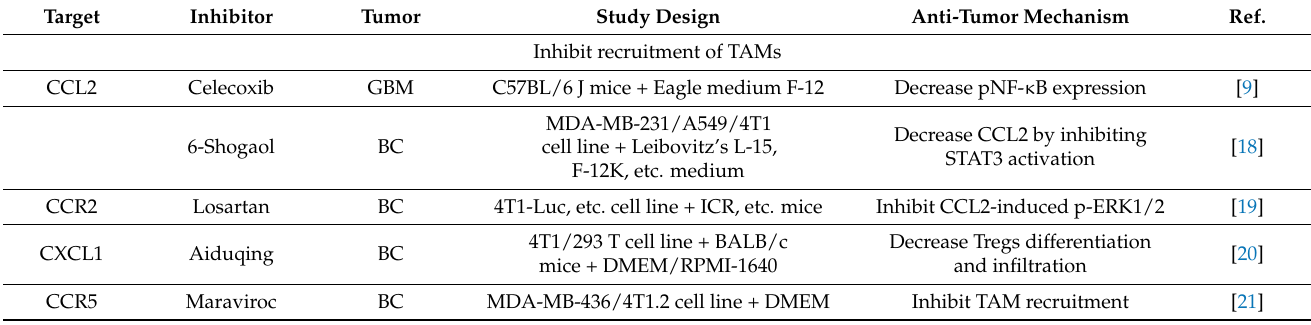
Figure 1. Targeting approaches for inhibiting TAM recruitment and polarization. TAMs are mainly recruited by the factors derived from stromal and tumor cells. These factors, including endosialin, chitinase 3-like protein (Chi3L1), C–C motif chemokine ligand 2 (CCL2), etc., could bind with their receptors in TAMs, then activating the downstream effectors to regulate the recruitment of TAMs through nuclear factor kappa-light-chain-enhancer of activated B cells (NF- κ B), phosphoinositide 3-kinase/protein kinase B (PI3K/Akt), mitogen-activated protein kinase (MAPK), etc. signaling pathways. Targeting inhibitors, including IgG78, celecoxib and GDC0623 block CD68, the NF- κ B and MEK signaling pathways inhibit TAM recruitment or reduce the number of TAMs. The polarization of TAMs is mediated by interleukins, extracellular proteins and metabolite. Tumor-derived Interleukin 4 (IL-4), IL-10, lactate and endothelial growth factor (EGF) could combine with IL4 receptor, IL-10 receptor, G-protein-coupled receptor 132 (Gpr132), and EGFR on TAMs to induce the polarization of TAMs via downstream signals, including PI3K/Akt/mTOR and signal transducers and activators of transcription 6 (STAT6) cascade. The chlorogenic acid, Let-7d, LY294002, mAb225 and YVAD could inhibit STAT6, IL-10 receptor, PI3K, EGFR and caspase-1 to attenuate TAM polarization. Table 1. Targeting proteins for inhibiting TAM recruitment and